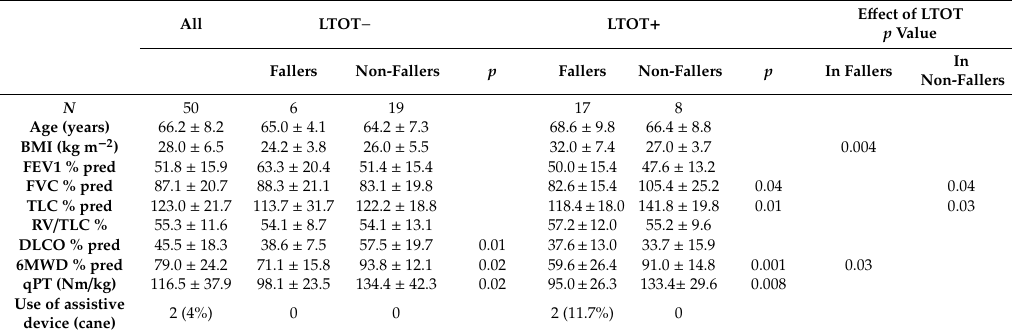
Table 1. Characteristics of study participants and pulmonary function test results in faller and non-faller groups, grouped according to long-term oxygen therapy (LTOT)